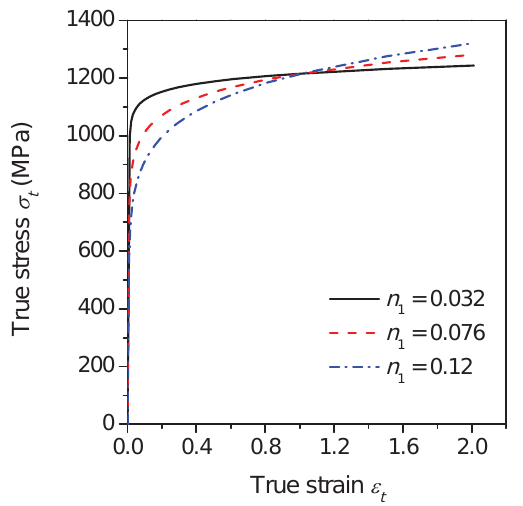
Figure 11. The true stress–strain curves of the grain interiors with the different strain hardening